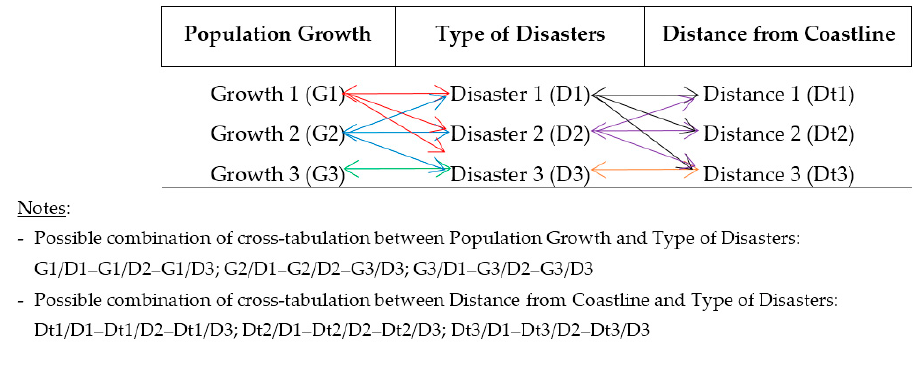
Figure 2. Typology of map overlay analysis.